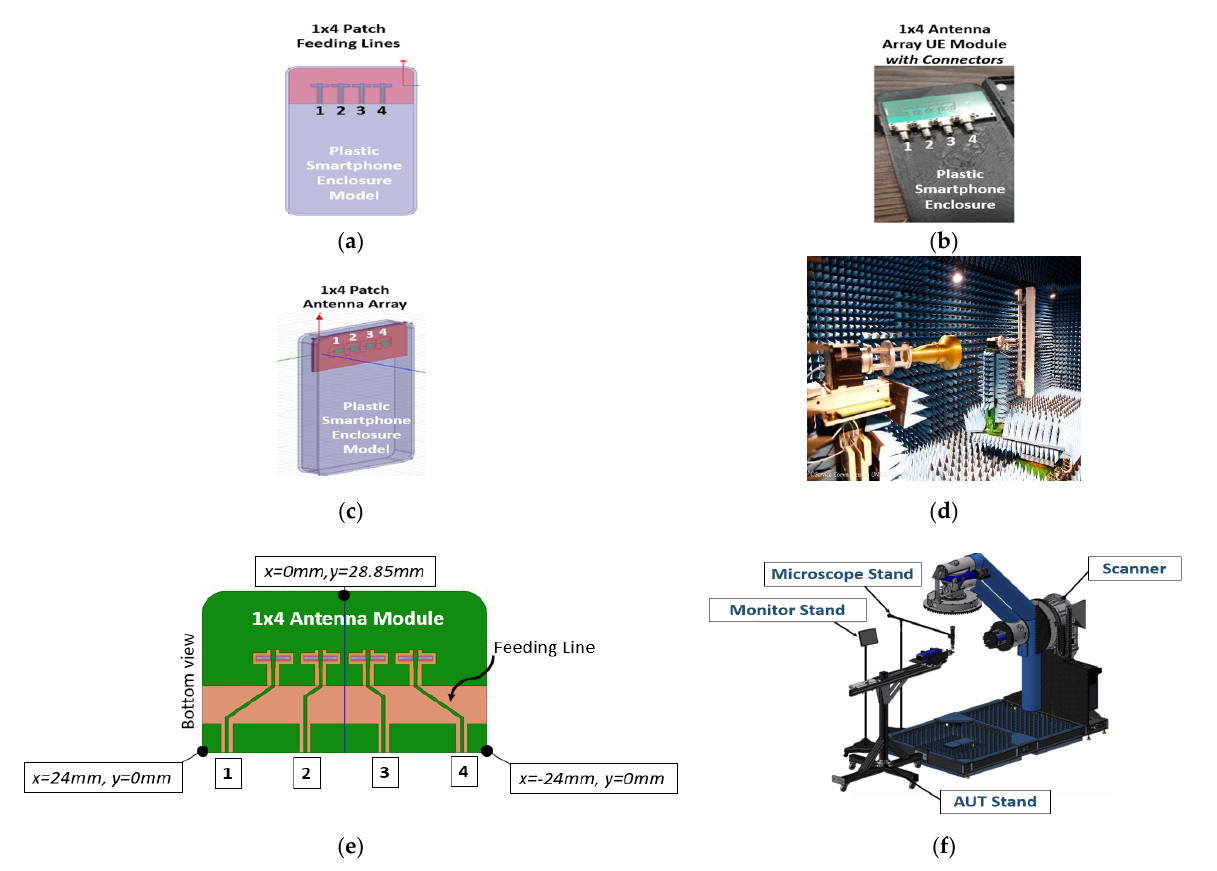
Figure 2. Experimental 26 GHz DUT with connectorized 1 × 4 antenna array in user equipment ( a ) and associated 3D model including enclosure ( b ) and feeding lines ( c ) built using full-wave solvers in time and frequency domains. DUT near-field scanning area for power and energy density measurement ( e ). Three-dimensional near-field ( d ) and far-field OTA scanning ( f ) solutions. Figure 2d,f shows the experimental setup for 3D near-field and far-field OTA scanning systems. The single-element S11 ≤ − 10 dB impedance bandwidth is from 24.25 to 27.5 GHz, as shown in Figure 3 comparing measurement and simulations using 3D full-wave solvers.